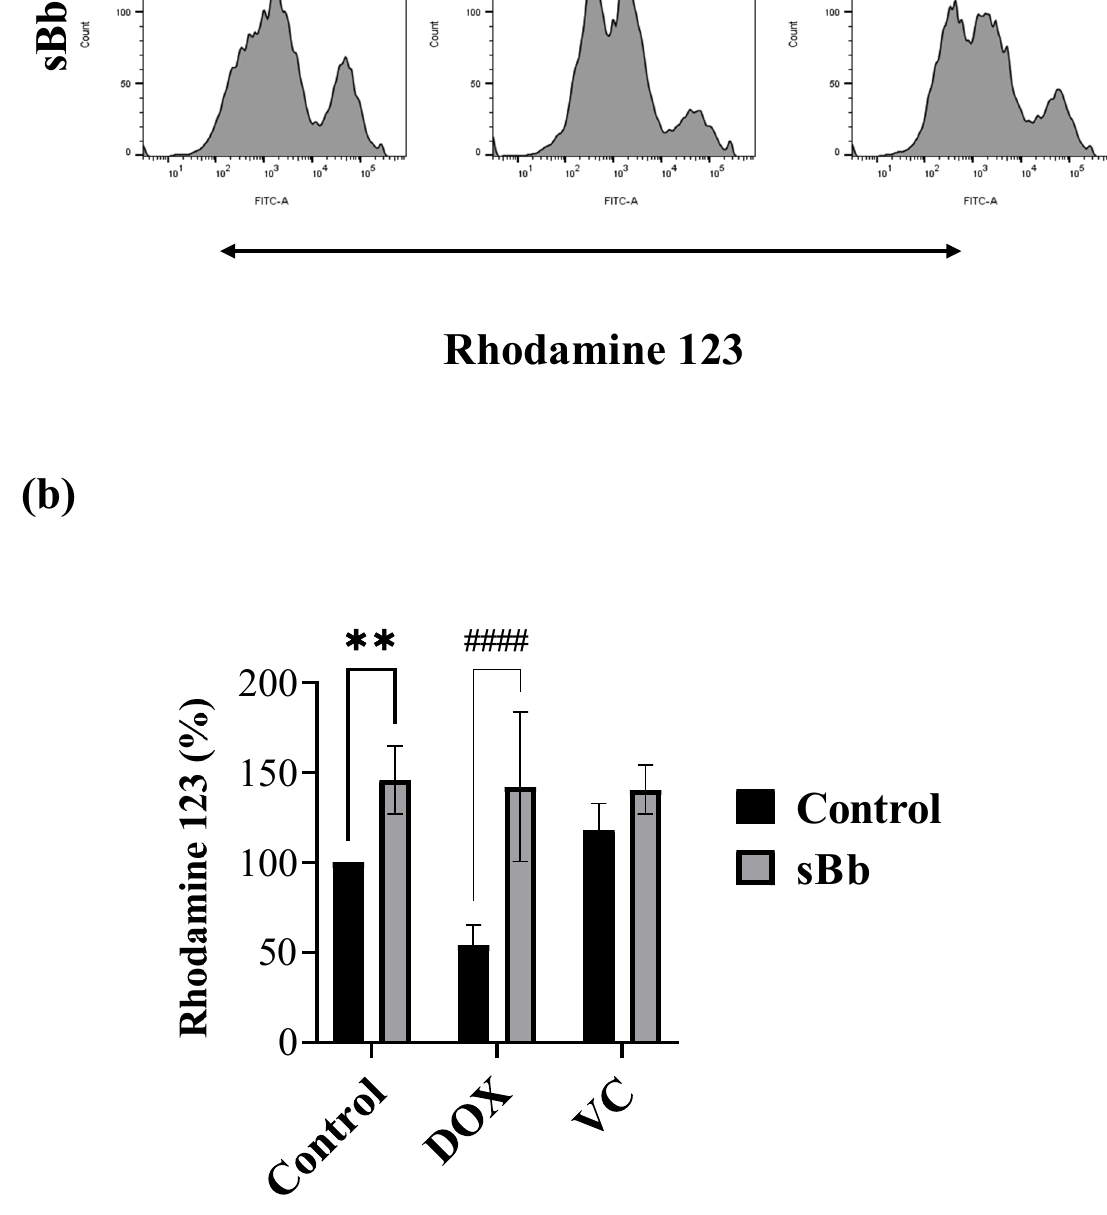
Figure 3. sBb increases the MMP of DOX-treated DCs. The DCs treated with DOX, VC, and/or sBb were stained with Rhodamine 123 solution and flow cytometric analysis was performed. ( a ) A representative histogram set was presented. The numbers in the upper part of the histogram indicate mean fluorescence intensity. ( b ) The graph was generated from 5 independent experiments. The mean fluorescence intensity of control DCs was set at 100%. ** indicates p < 0.01 compared to control DCs, whereas #### indicates p < 0.0001 compared to the treated DCs in the absence or presence of